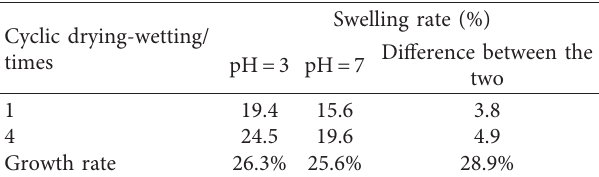
Figure 4: Swelling rate of the sample under acid rain and cyclic Table 2: The expansion rate of the sample under different conditions.